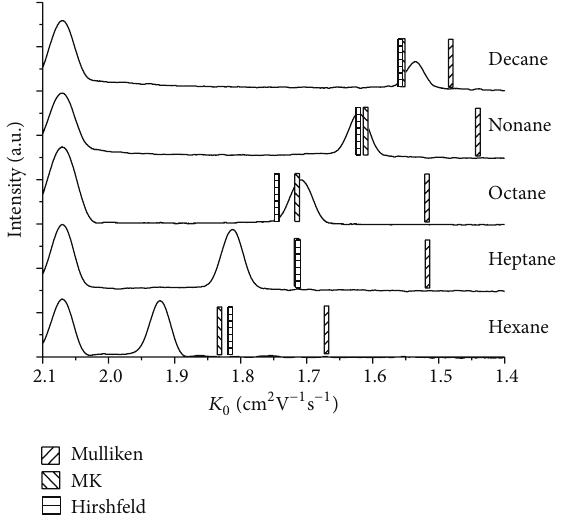
Figure 2: Experimental IMS spectra for n-alkanes (solid lines) and the calculated mobilities (bars). The peak at 2.07 cm 2 V −1 s −1 is created by the reactant ions and thus present in all alkane